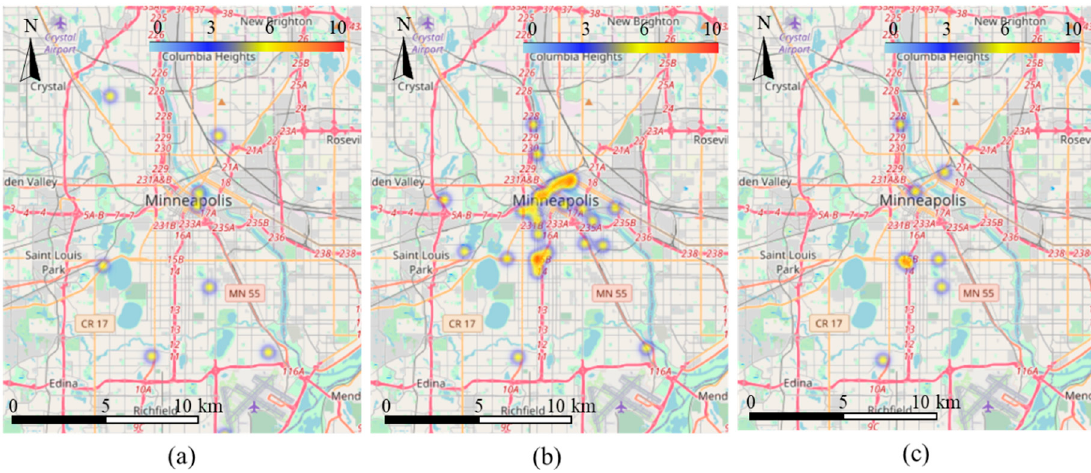
Figure 12. Hotspots of burglary in Minneapolis, MN ( a ) 21 May 2020; ( b ) 28 May 2020; ( c ) 4 June 2020